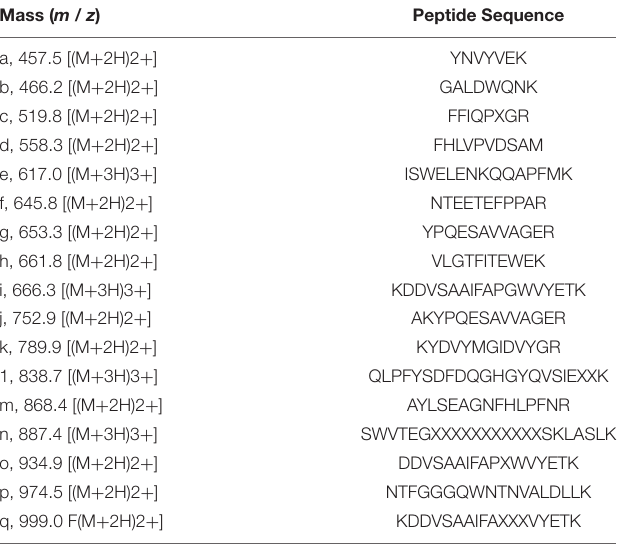
TABLE 2 | MS/MS analysis of internal amino acid sequence of purified